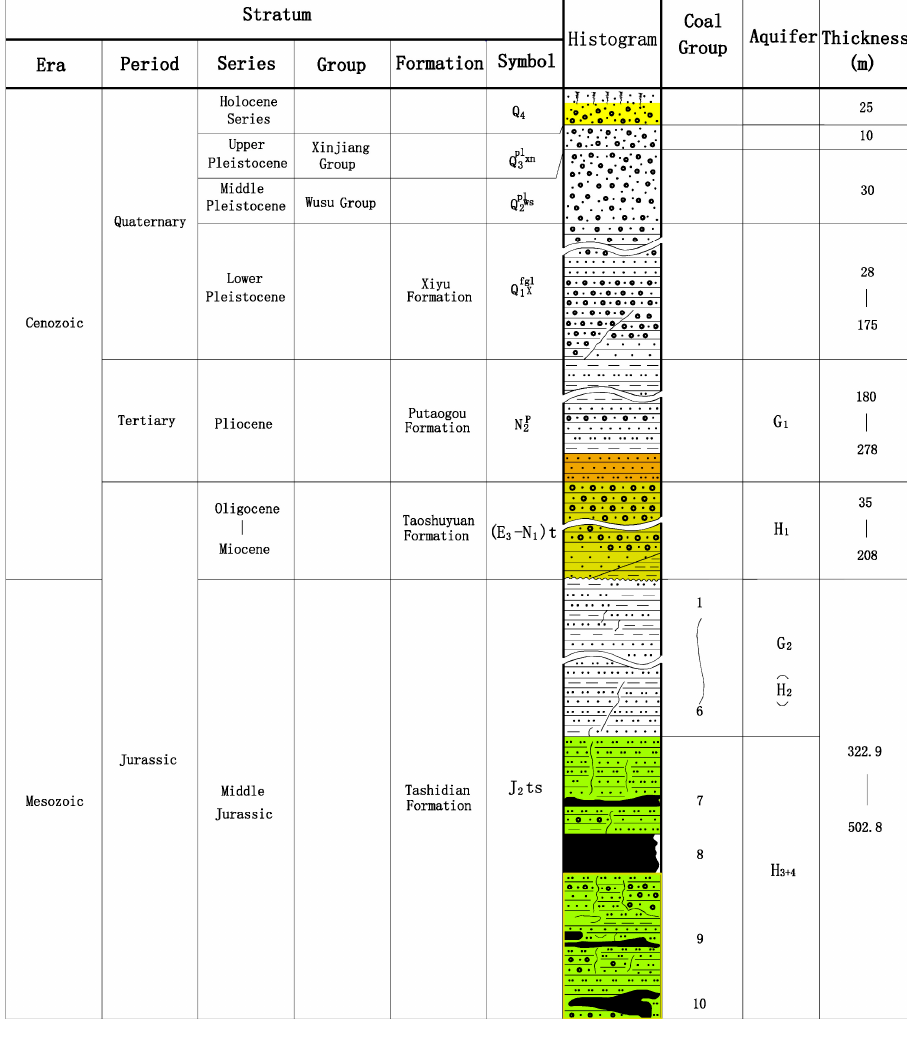
Figure 2. Synthetic hydrogeological histograms of Tashidian Erjingtian Mine. Table 1. Aquifer pumping test results